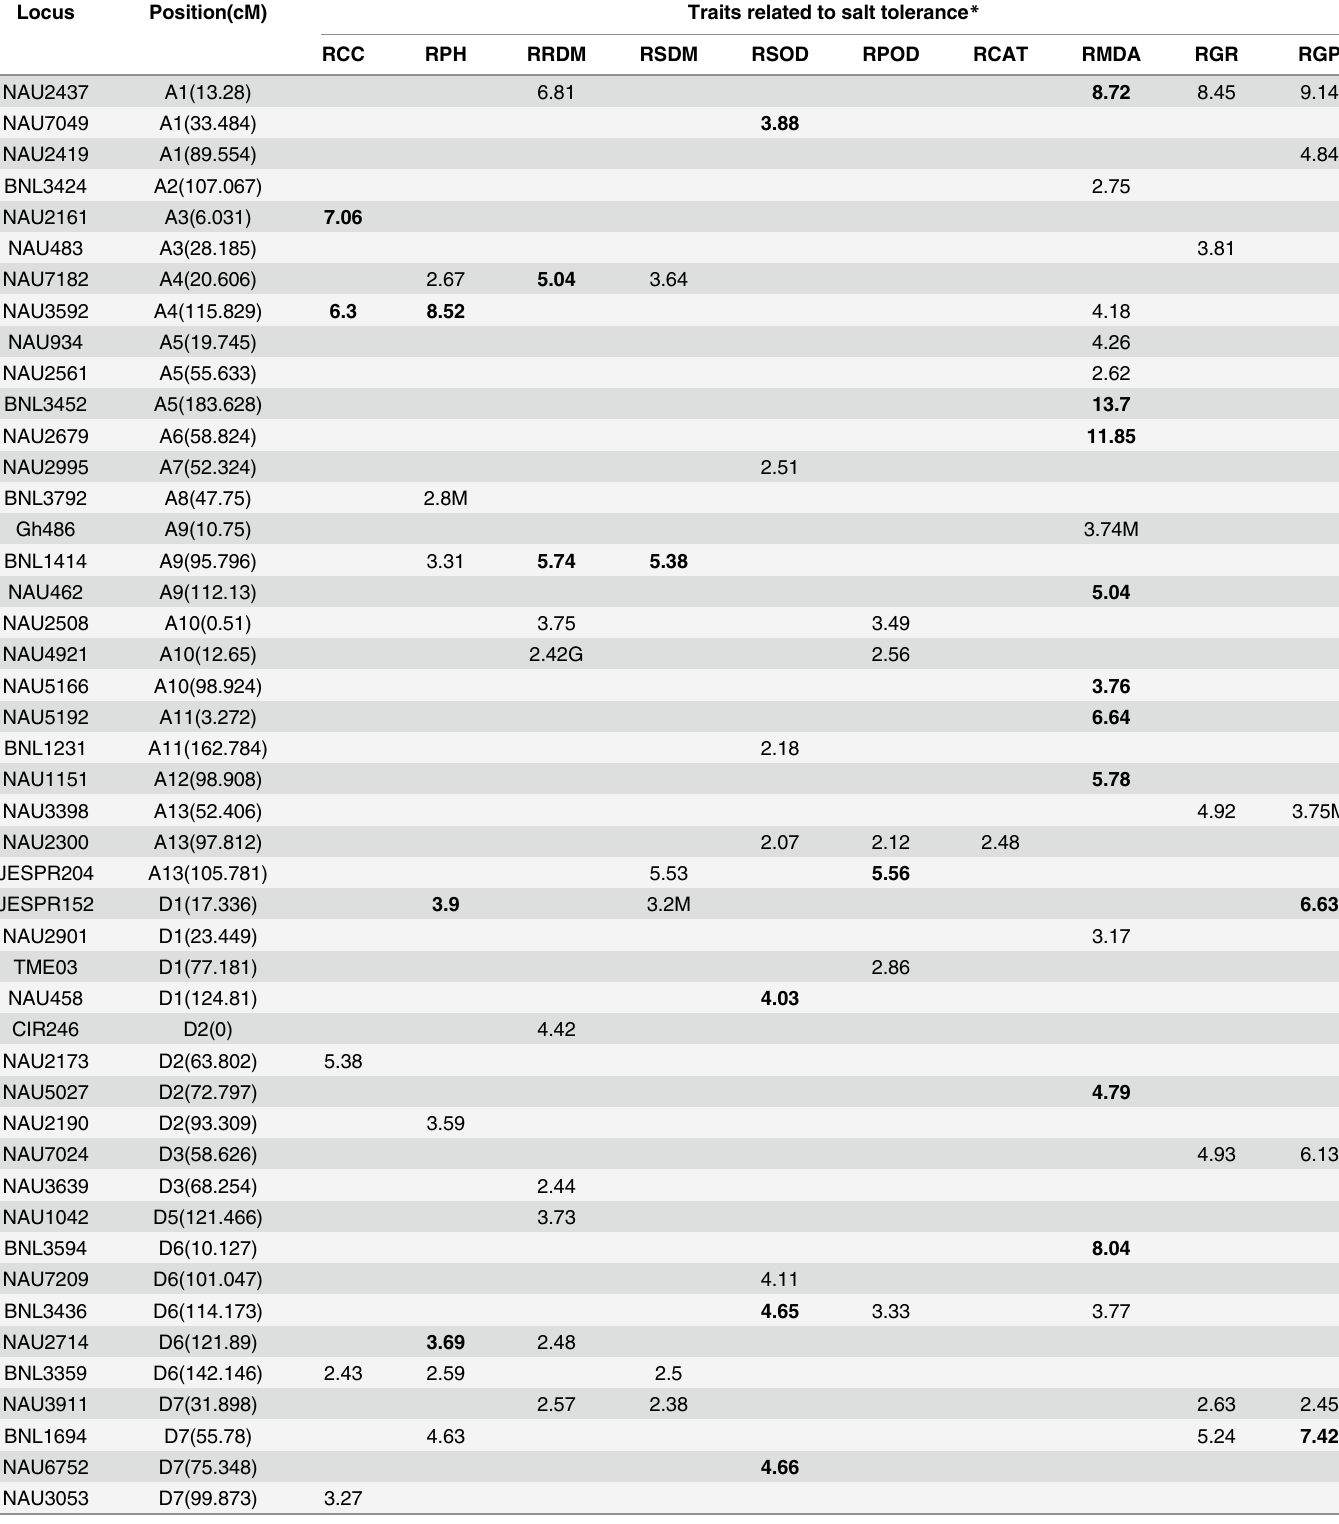
Table 2. Marker loci associated with traits and their explained phenotypic variation in cotton cultivars. Locus